Question: What visual encoding does this figure use to show its data?
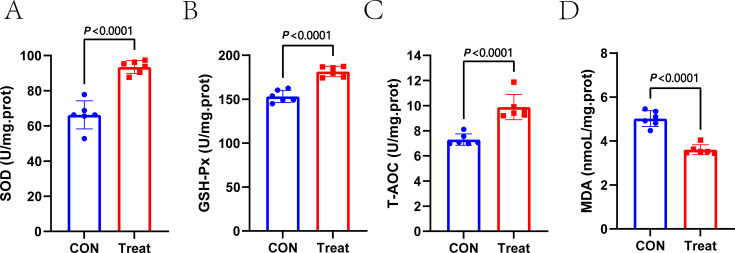
Answer: bar